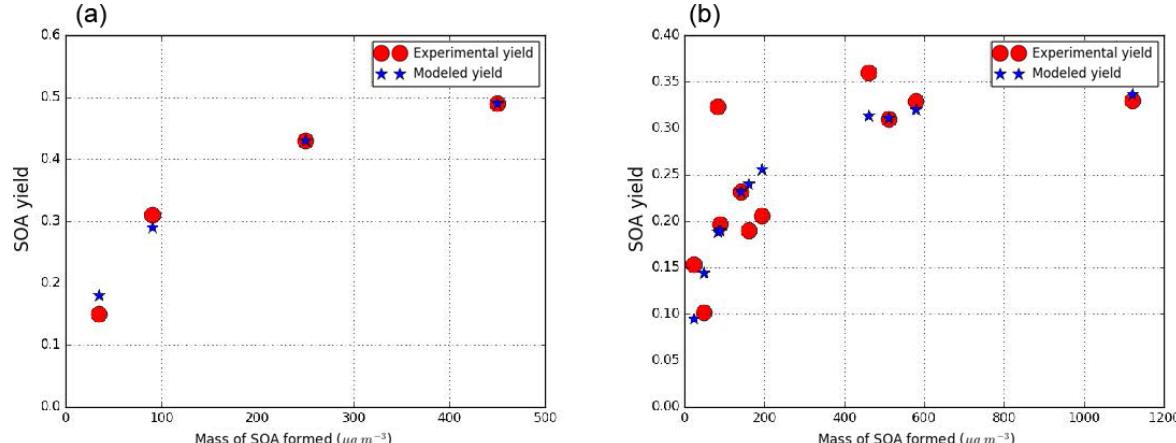
Figure 3. SOA experimental and modeled yield data from smog chamber for syringol under low-NO x conditions (a) (experimental data from Chhabra et al., 2011; Yee et al., 2013) and under high-NO x conditions (b) (experimental data from Yee et al., 2013; Lauraguais et al., 2012).